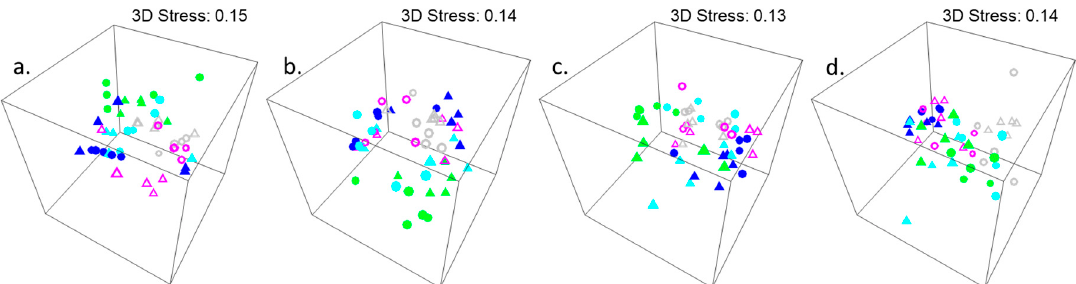
Figure A2. Non-metric multidimensional scaling (nMDS) plots of understorey cover assemblages associated with different levels (full cover = dark blue, patchy cover = aqua, negligible cover = green, thinned = pink, removed = grey) of Hormosira cover ( a ) 1 day, ( b ) 5 days, ( c ) 15/19 days and ( d ) 371/379 days following manipulation at each of two sites (13th Beach = triangles, Bridgewater Bay = circles). All data were fourth-root transformed. 3D nMDS plots based on Bray-Curtis dissimilarities are shown where stress exceeded 0.20 for 2D plots.